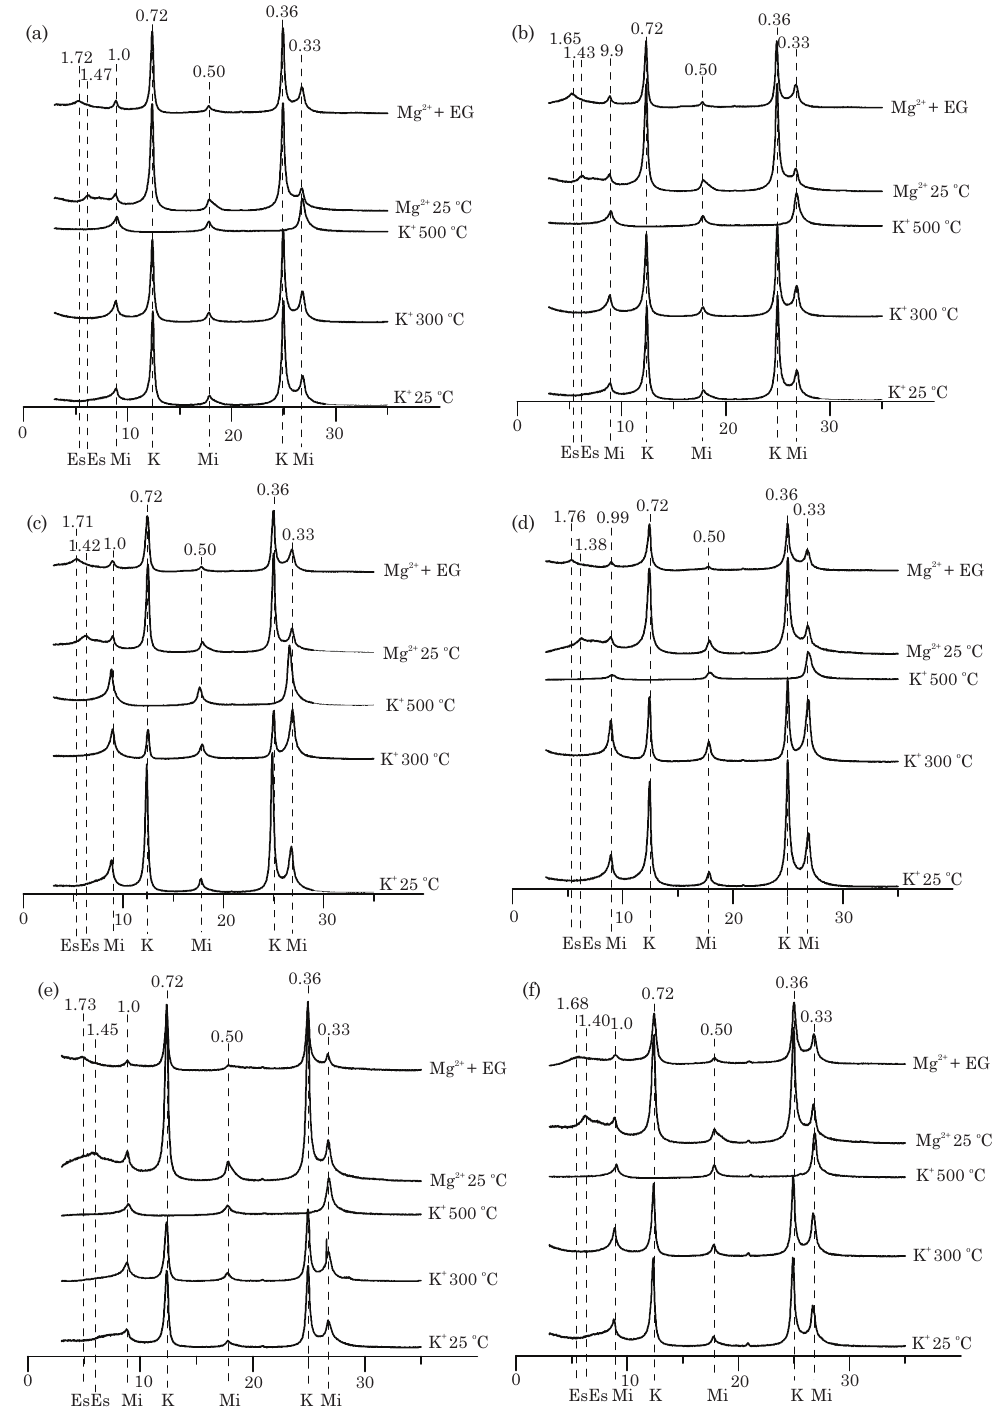
Figure 6. Diffractograms (°2 θθθθθ CuK ααααα ) of total clay in horizons after (a, c, e) and before (b, d, f) the avulsion process in AP1: (a) 30-75 cm - post, (b) 145-200 cm - pre; AP4: (c) 30-45 cm - post, (d) 150-190 cm - pre; and AP10: (e) 105-150 cm - post. K=Kaolinite, Mi=Mica,